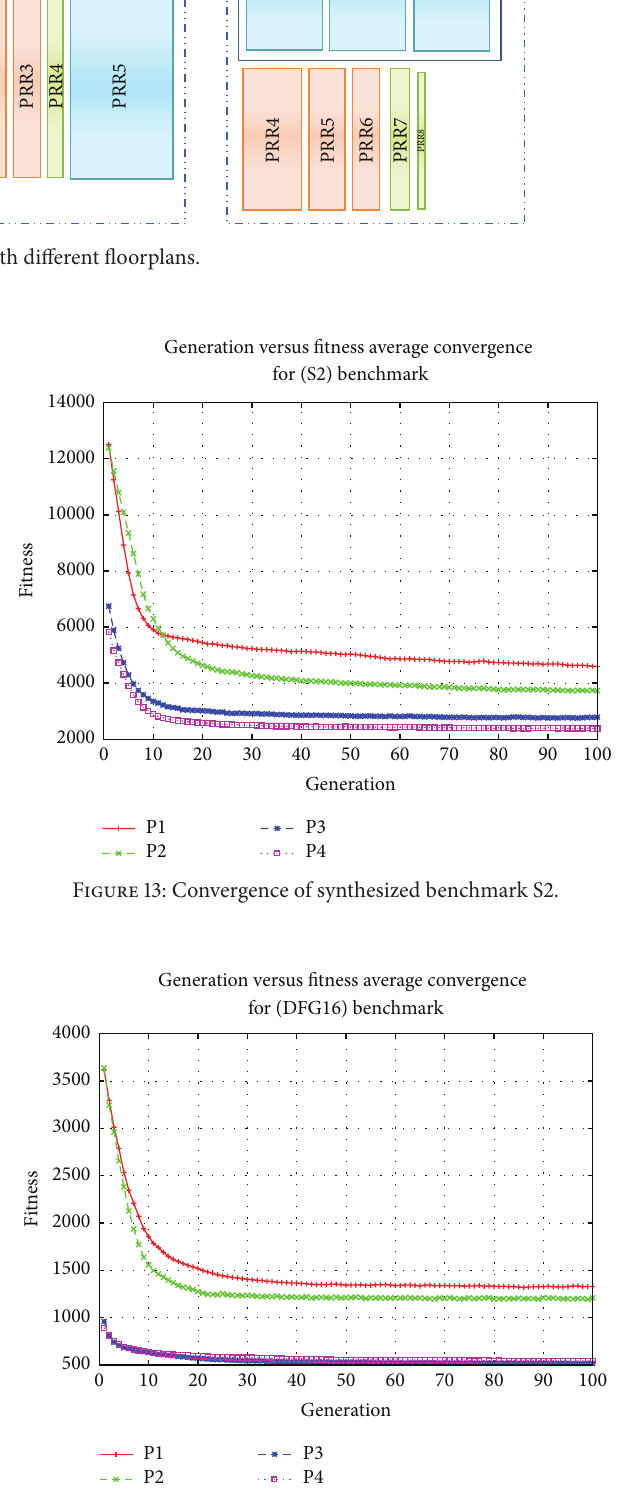
Figure 14: Convergence of MediaBench benchmark